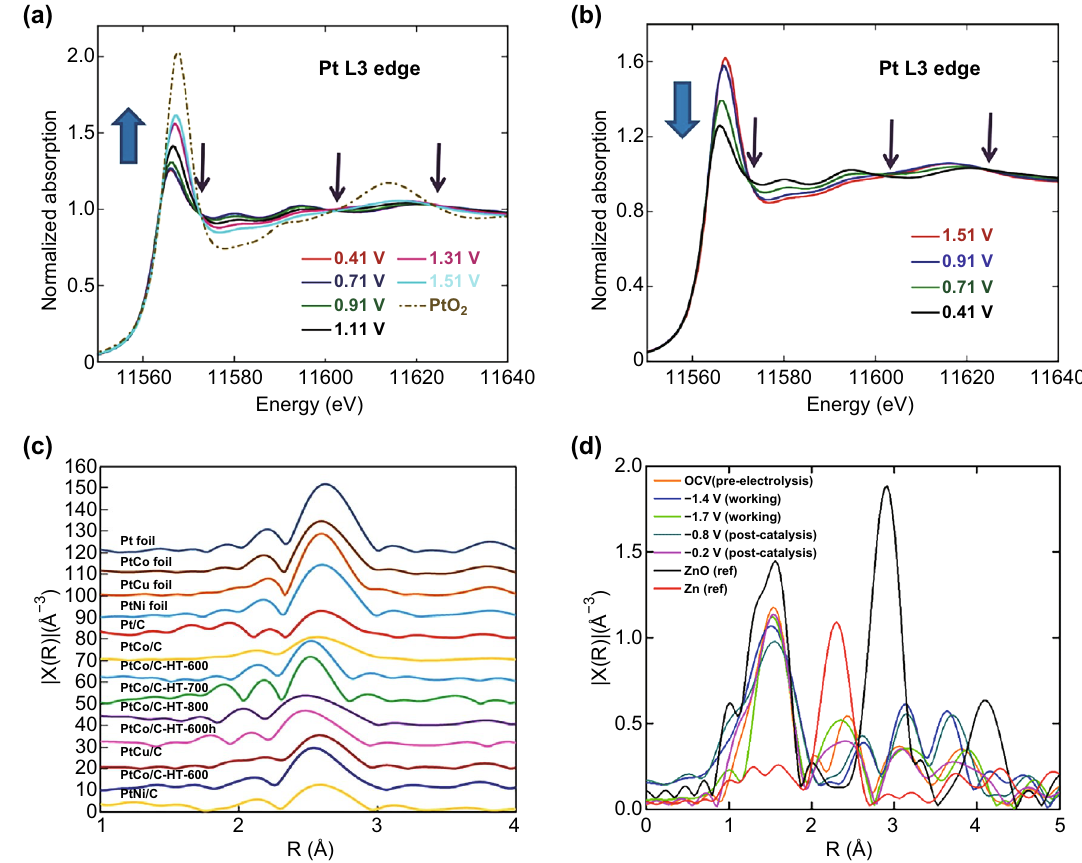
Fig. 3 In situ XANES for Pt L 3 edge of carbon-supported Pt nanoparticles at potentials a ascending from 0.41 to 1.51 V and b descending from 1.51 to 0.41 V in 1 M HClO 4 . Also shown (yellowish green dashed line) is ex situ XANES from commercial PtO 2 . Three distinct isosbestic points are observed at 11.573, 11.603, and 11.624 keV as designated by arrows. Reprinted with permission from Ref. [35]. c Fourier transform of k 3 -weighted Pt-L III edge EXAFS oscillation of Pt foil, PtCo, PtCu, PtNi alloy foils, Pt/C, PtCo/C, PtCo/C-HTs, PtCu/C, PtCu/C-HT, and PtNi/C at 0.4 V versus RHE. Reprinted with permission from Ref. [38]. d Fourier transforms of Zn K-edge EXAFS spectra of the PorZn catalyst electrode at different potentials (V vs. SHE). ZnO and Zn are used as references. Reprinted with permission from Ref.